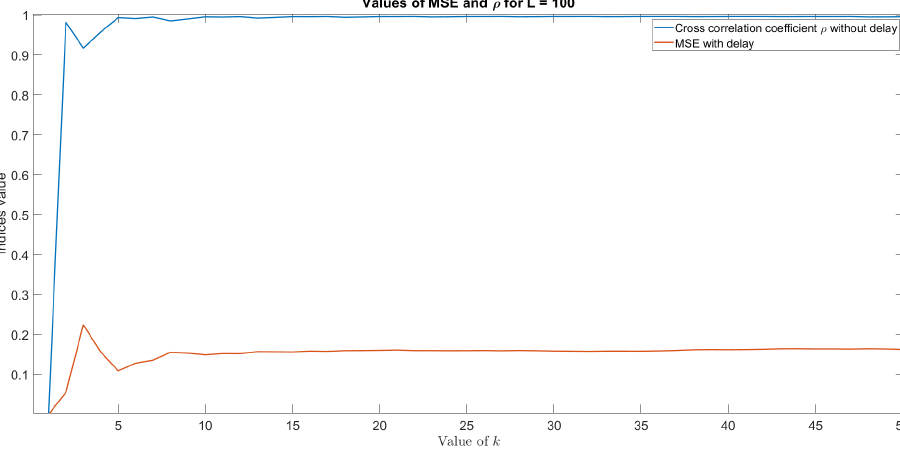
Figure 4. Values of the MSE and ρ when L = 100 and k varies from 2 to